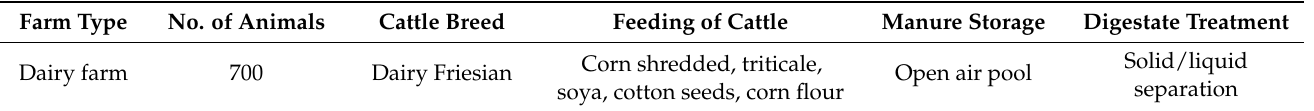
Table 2. Main characteristic of the